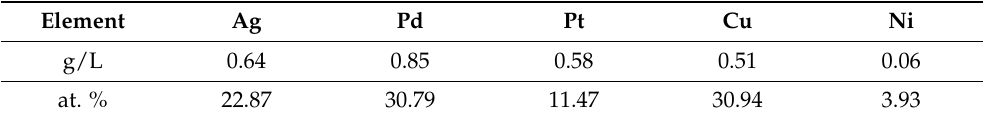
Table 2. ICP–OES analysis of the